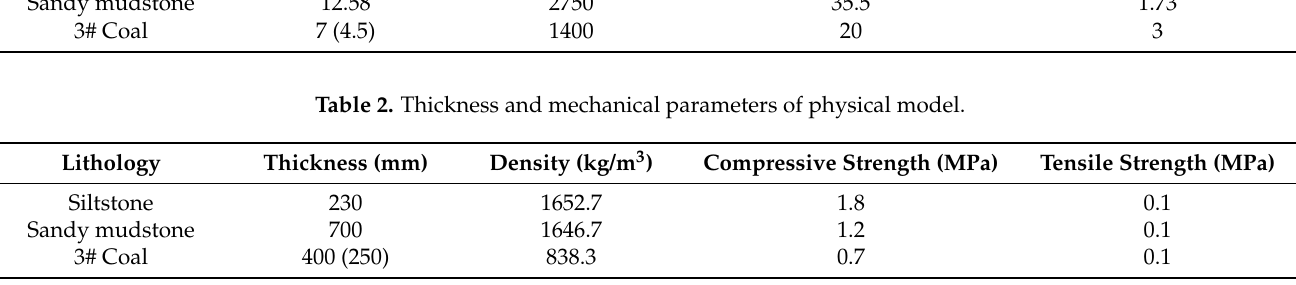
Table 1. Thickness and mechanical parameters of different strata.